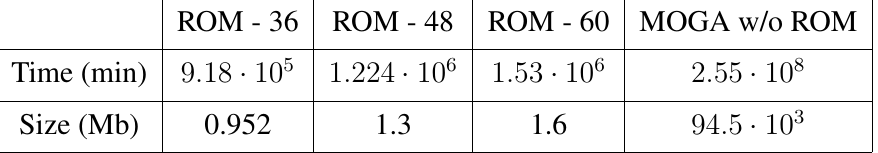
Table 5: Computational Efficiency